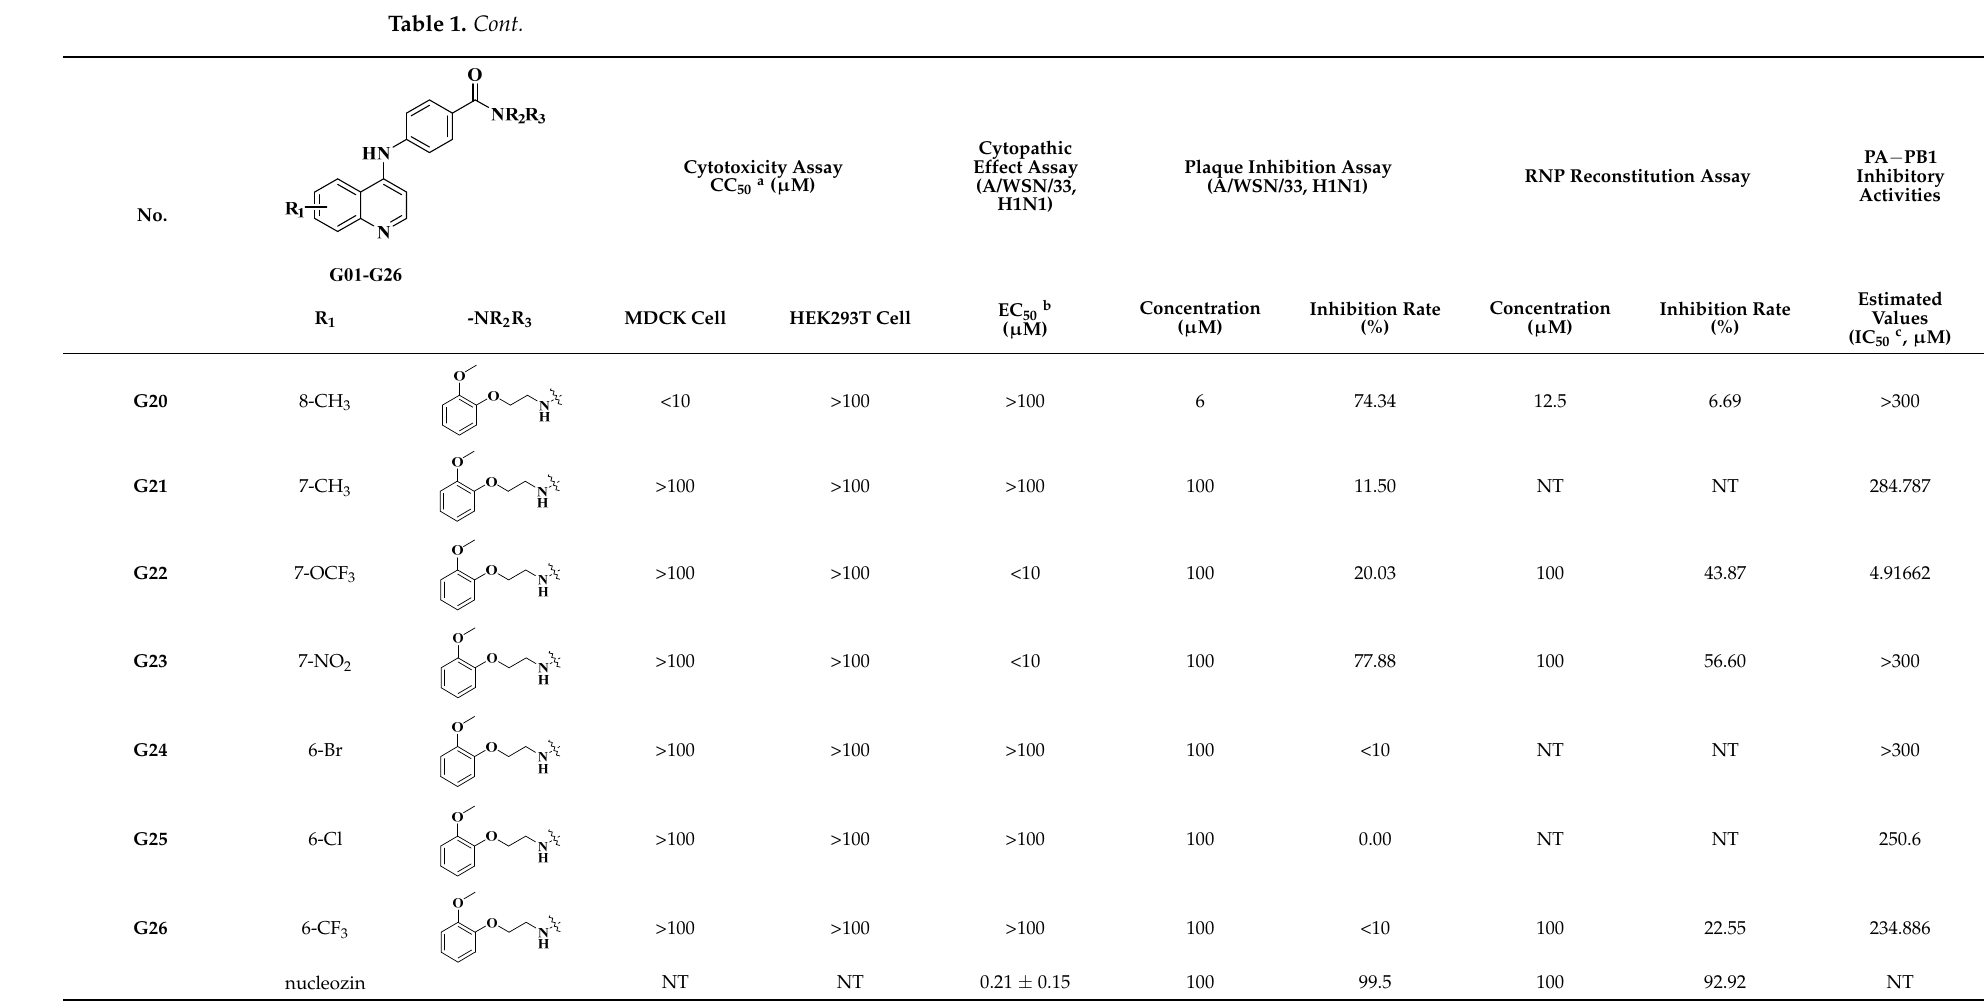
Table 2. The results of compounds in plaque inhibition assay.